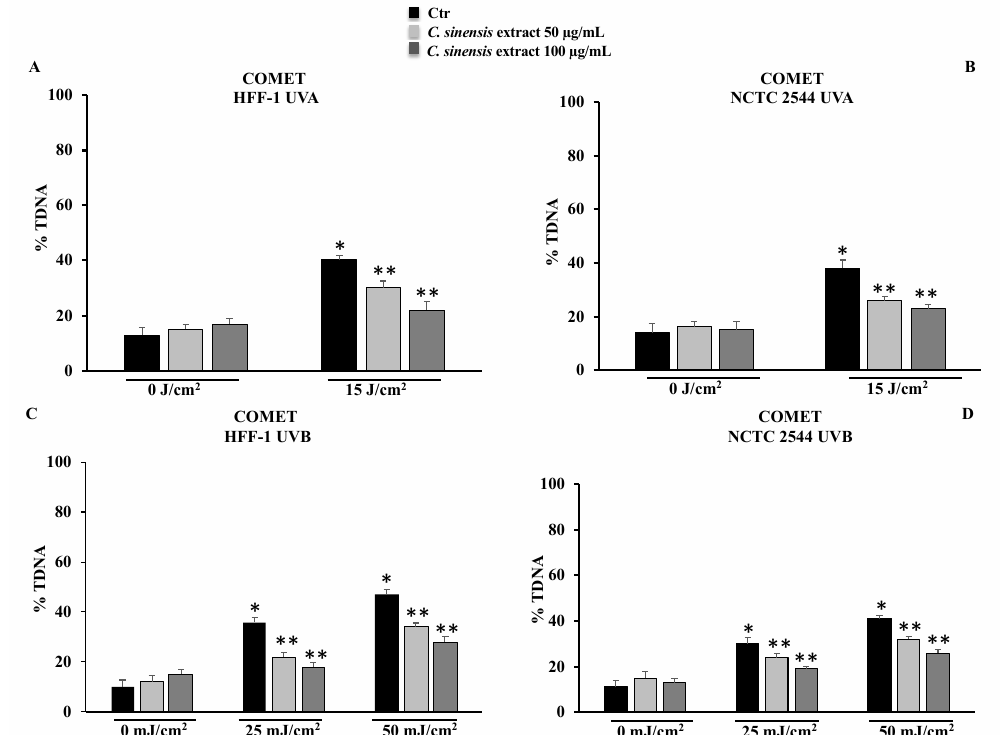
Figure 7. DNA damage was evaluated by alkaline comet assay in HFF-1 and in NCTC 2544 cells untreated and treated for 4 h with C. sinensis extract at different concentrations (50–100 µg/mL) and irradiated with UVA ( A , B ) and/or UVB ( C , D ). Results are expressed as percentage of DNA present in the comet tail (%TDNA). The data are reported as the mean ± S.D. from triplicate experiments. * Significant vs. untreated control cells: p ≤ 0.001; ** Significant vs. untreated irradiated cells: p ≤ 0.05.